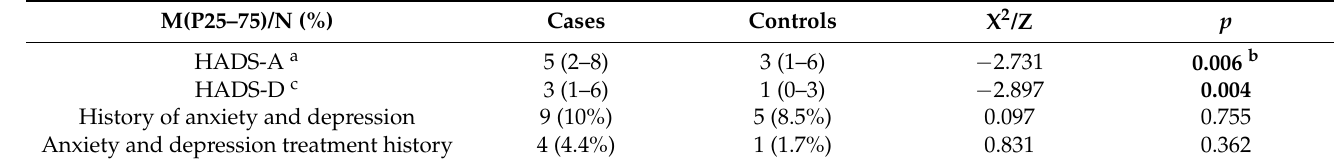
Table 3. Anxiety and depression in patients with and without